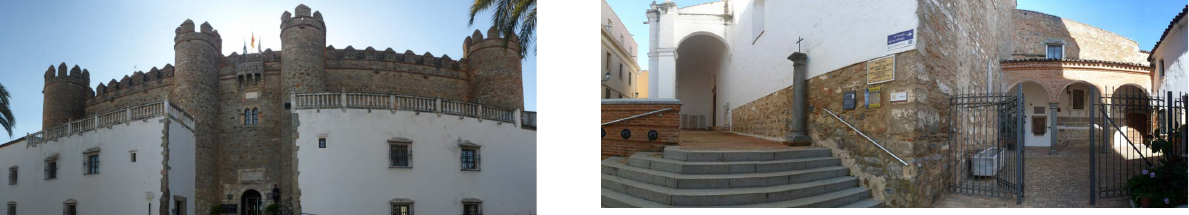
Figure 2. A modern panoramic view of the main facade of the Al- cázar de Zafra nowadays. From this palace, Count Don Pedro ob- served the ball lightning.